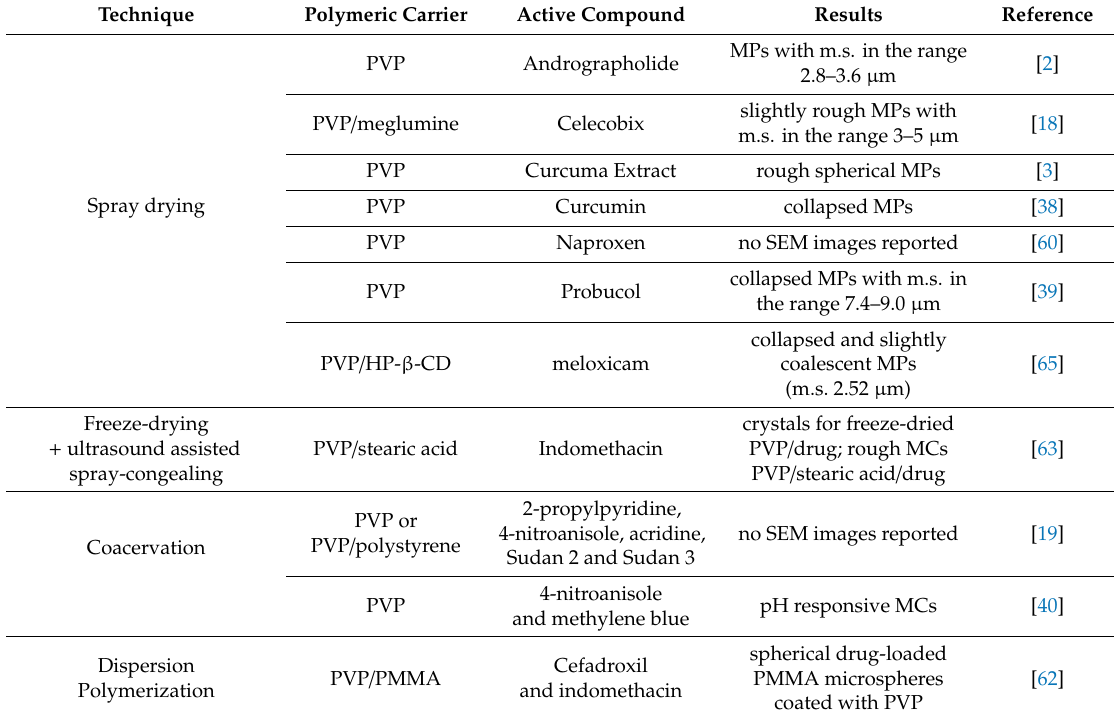
Table 1. PVP-based particles. HP- β -CD, hydroxypropyl- β -cyclodextrin; MCs, microcapsules; MPs, microparticles; m.s., mean size; NPs, nanoparticles; PMMA, poly(methyl methacrylate); MPR, m-methylphenol-formaldehyde resin; PAA, poly(acrylic acid); PAH, poly(allylamine hydrochloride); PMA, poly(methacrylic acid); SMPs, submicroparticles; PMs, polymeric micelles; PDLLA, poly( d , l